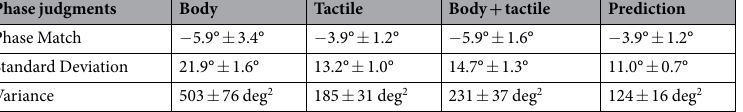
Table 1. The parameters of the best fit Gaussians for all conditions. The numbers are the averages of the fits to each individual’s data. Standard errors are